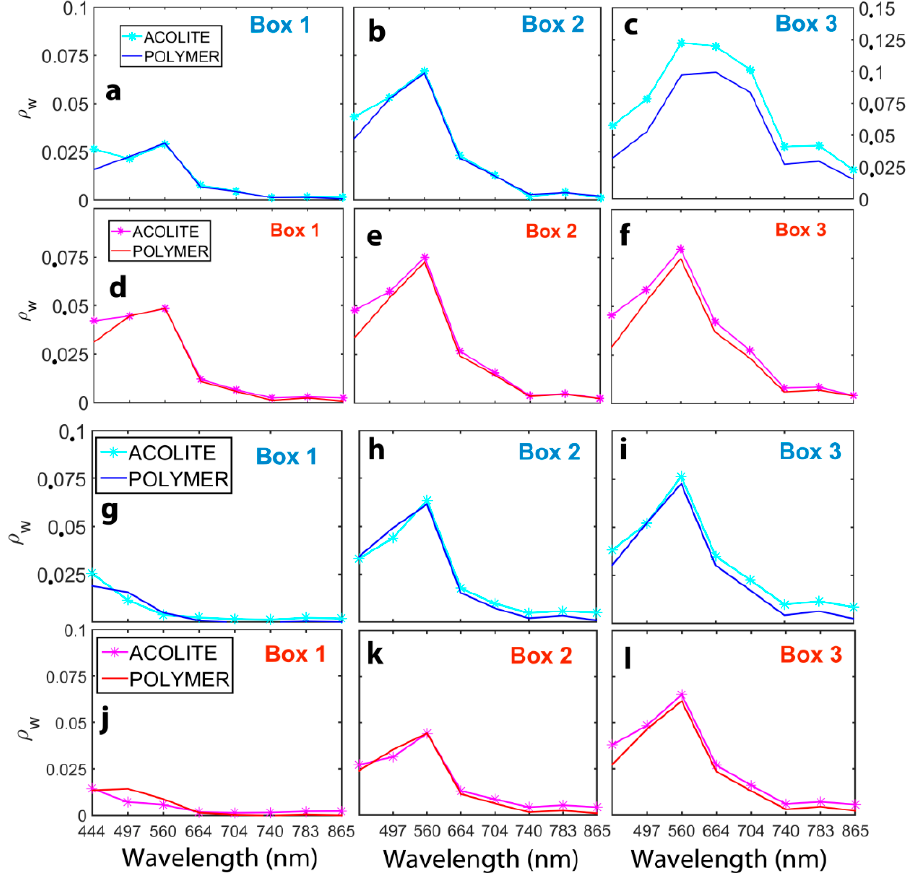
Figure 7. Mean water reflectance spectra ( ρ w) extracted from the 5 × 5 pixels in the Guadalquivir estuary and Cadiz Bay after correction with ACOLITE (cyan and magenta lines) and POLYMER (blue and red lines). The location of the boxes is shown in Figure 1 ranging from offshore waters (Box 1) to estuarine or turbid waters (Box 2 and Box 3). The scenes corresponded to 8 March 2016 ( a – f ) and 24 September 2016 ( g – l ). All y-axes are the same except (c).